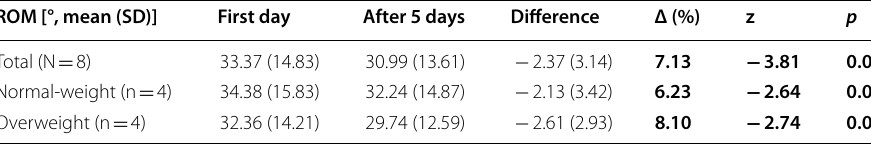
Items in bold: significant t-value